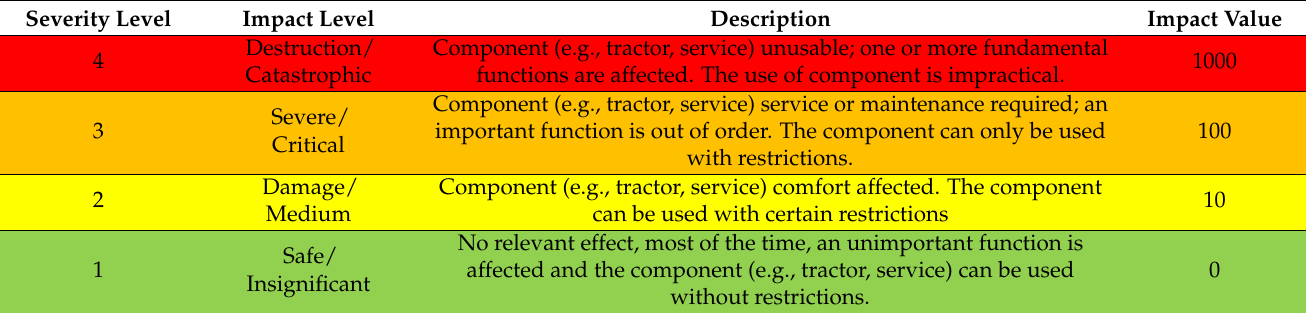
Table 19. Cybersecurity: severity (impact)—operational.